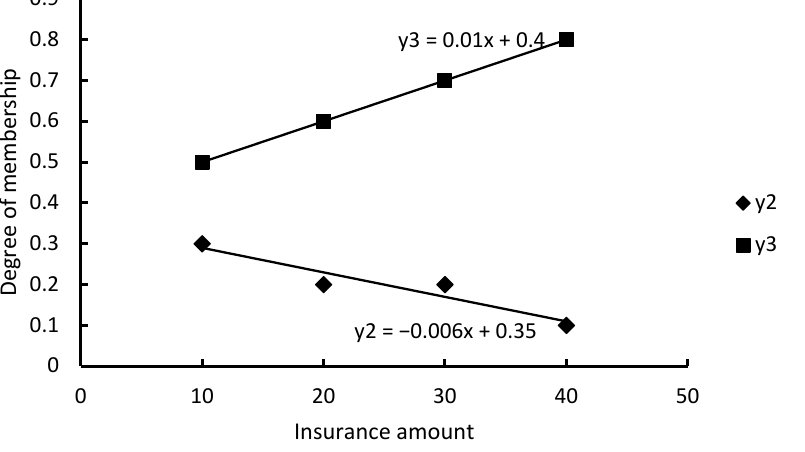
Figure A22. Single factor evaluation for the index of insurance amount (more than 10 ten thousand yuan).